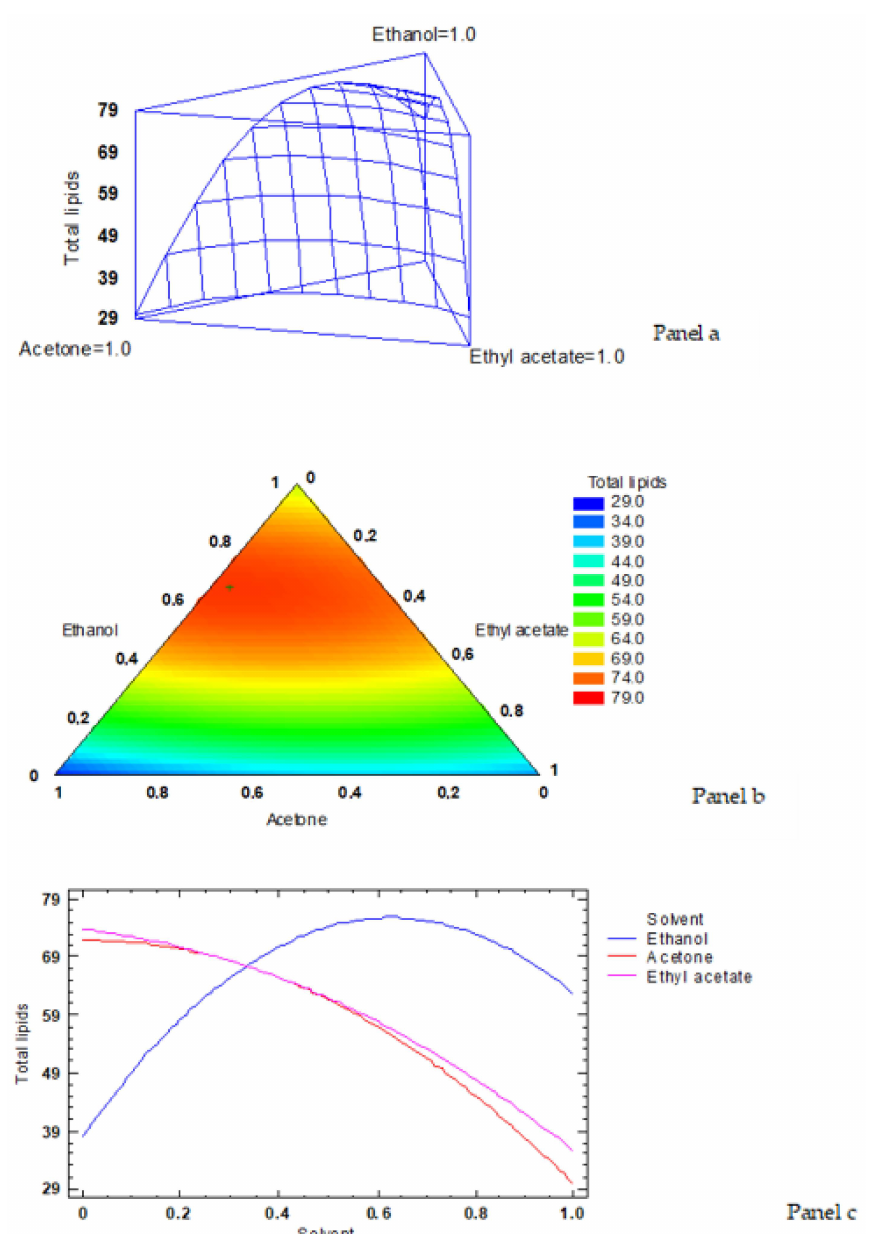
Figure 1. Application of the simplex-lattice design on the fitting model corresponding to lipid content (g · kg − 1 by-products) results. Panel a : estimated response surface; Panel b : contours of estimated response surface; Panel c : trace plot for lipid